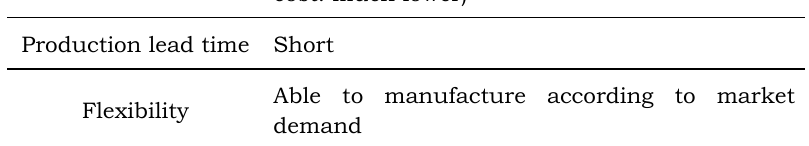
Table 1. Competitiveness of minimill steel technology (when compared with integrated steel) Inferior (targeting mainly low-grade products; Quality showing quality improvement) Low Cost (construction cost: less than 10 ％ ; operating cost: much lower) Production lead time Short Able to manufacture according to market Flexibility